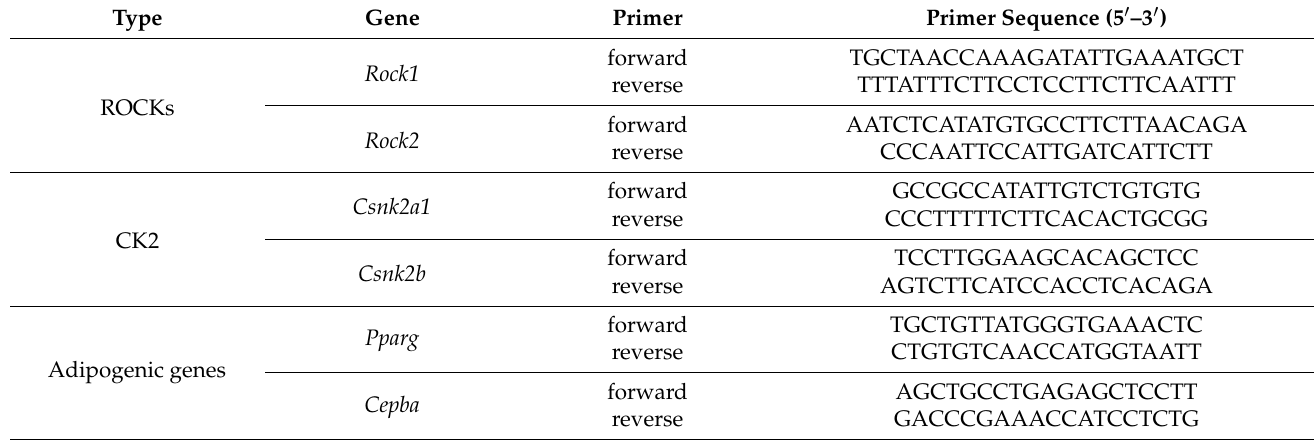
Table 2. List of PCR primers and sequences.